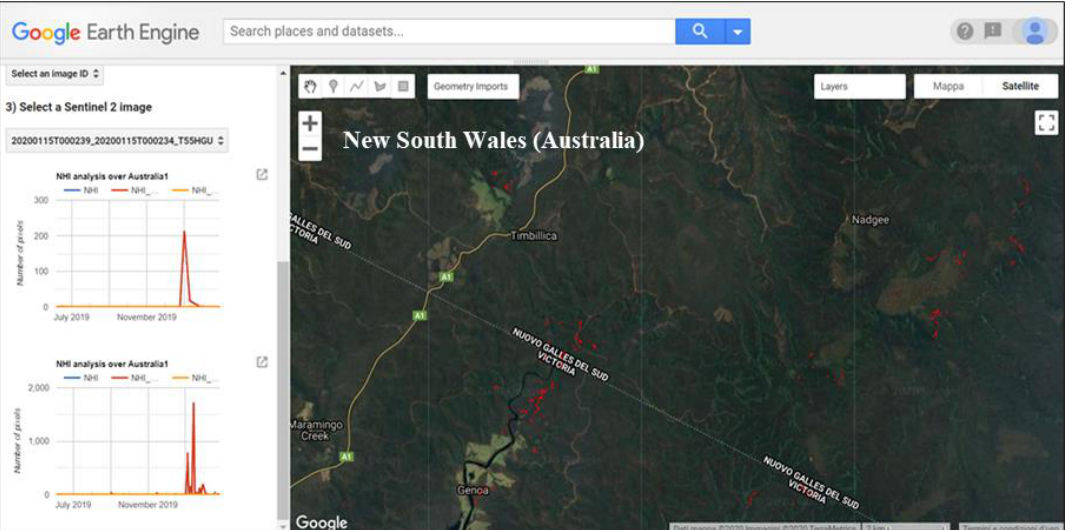
Figure 15: Forest fires (red pixels) identified and mapped by the NHI algorithm, under the GEE environment, on a S2-MSI scene of 15 January 2020 covering the New South Wales region (Australia).